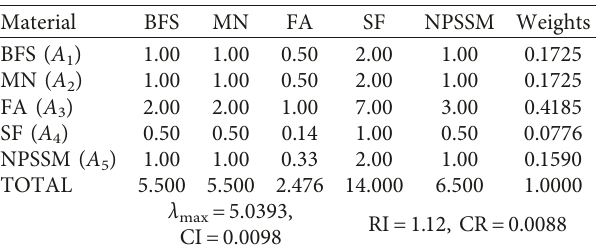
Table 4: Pairwise comparison of OSM-ranked concrete supple- mentary